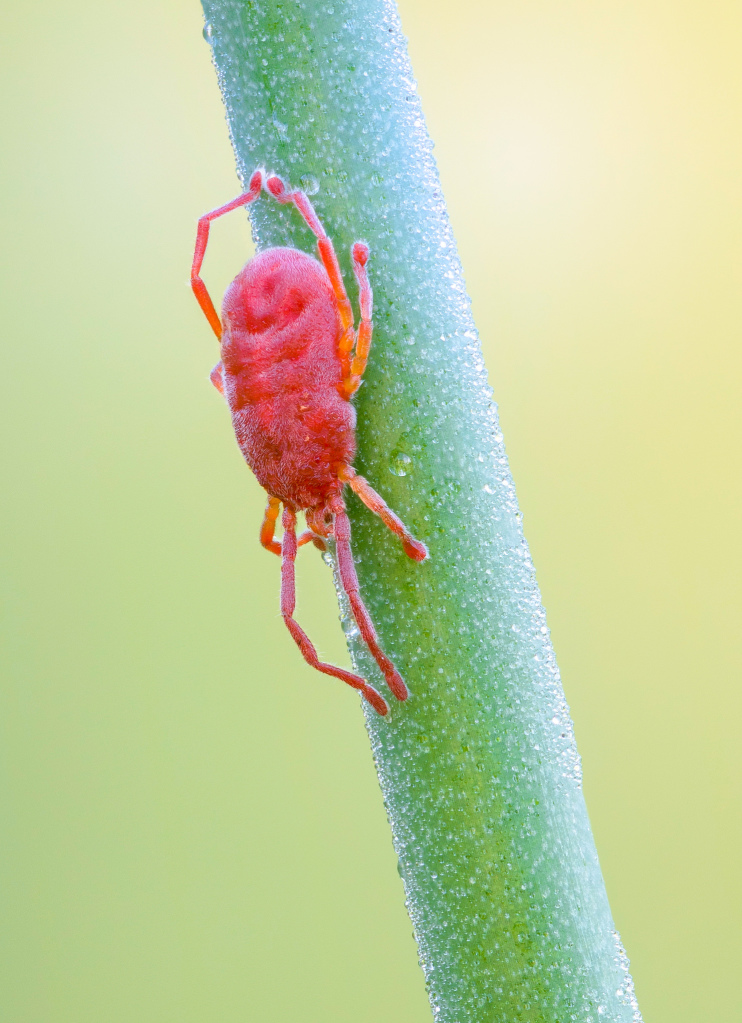
Abrolophus sp. Photo John Hallmen.